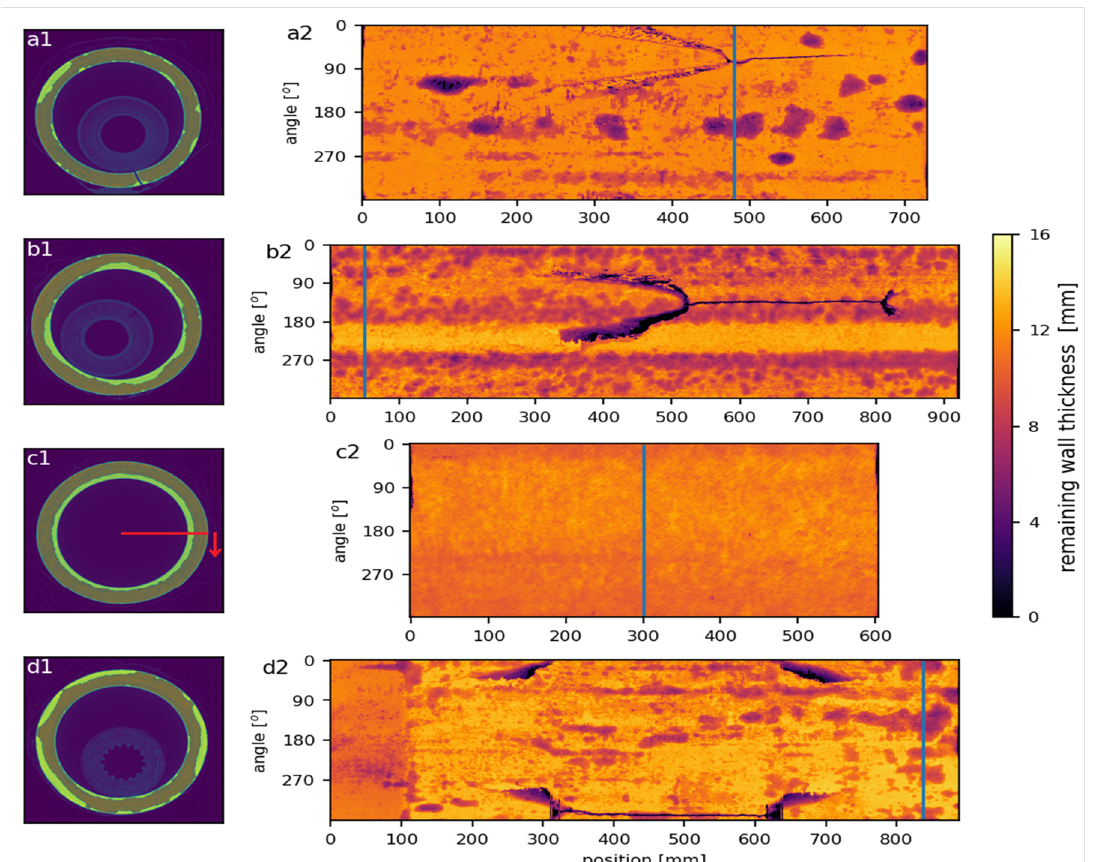
Figure 2. Four examples of degradation patterns of AC pipes as measured with CT. The ID’s of the pipes in Table 1 are 103679 ( a ), 168218 ( b ), Blerick4 ( c ), and D161290 ( d ). The cross-sections ( a1 – d1 ) are the CT slices at the locations marked with the blue lines in the corresponding height maps of the pipes ( a2 – d2 ). The height maps indicate the remaining wall thickness of a pipe as a function of the angle around and position along the longitudinal pipe axis. The horizontal red line and the red arrow in ( c1 ) demonstrate the origin and direction of the vertical angle axes in ( a2 – d2